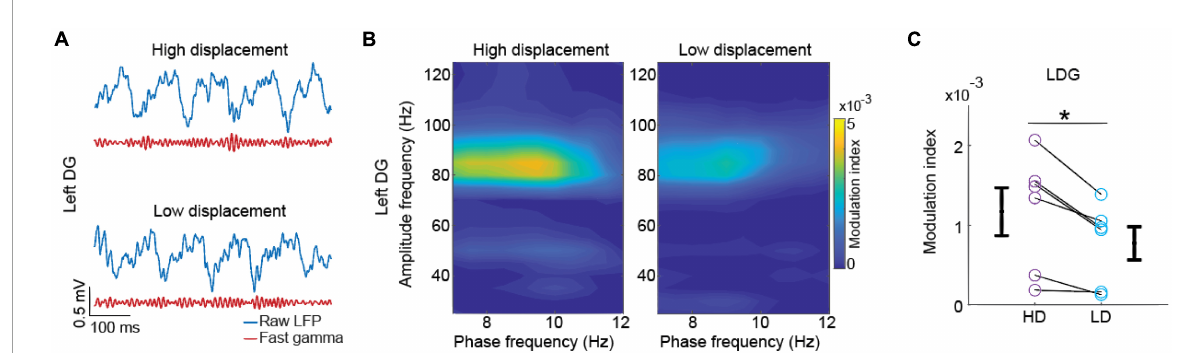
FIGURE4 Phase-amplitude cross-frequency coupling between theta and fast gamma oscillations in the dentate gyrus during high displacement (HD) and low displacement (LD) tests. (A) Raw local field potentials (LFP) signals (blue) and their respective fast gamma-filtered components (red) obtained from the left DG during object exploration in the high and low spatial displacement tests (upper and lower, respectively). (B) Representative theta-gamma phase-amplitude modulation in the left DG during object exploration in high and low displacement tests (left and right, respectively). (C) Average modulation index between theta phases and fast gamma amplitude in the left DG during high and low displacement tests (purple and cyan, respectively). Circles represent modulation index for individual rats and error bars represent SEM. Asterisk indicates statistical significance in a paired t test, n = 6 animals.